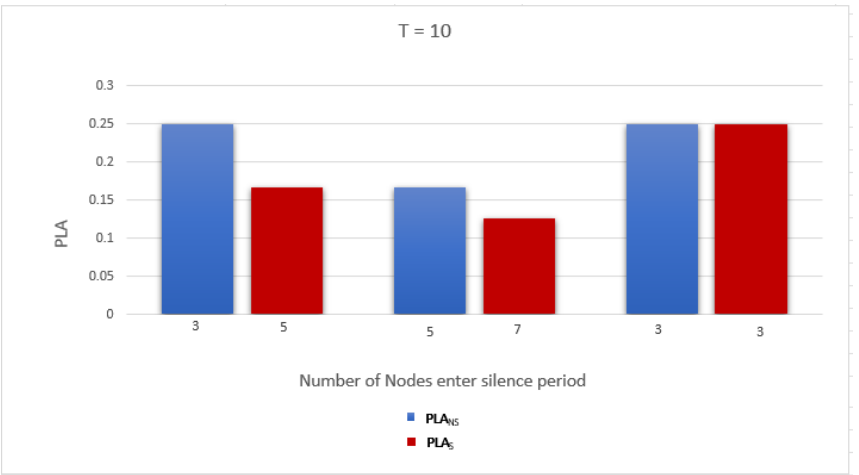
Figure 11. Probability of linkability (PLA) of the source node in a network with 10 nodes.